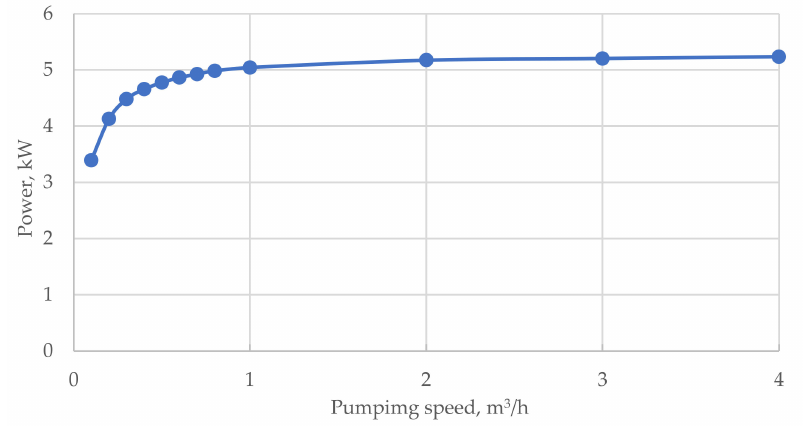
Figure 6. Dependence of stack power on electrolyte flow rate.